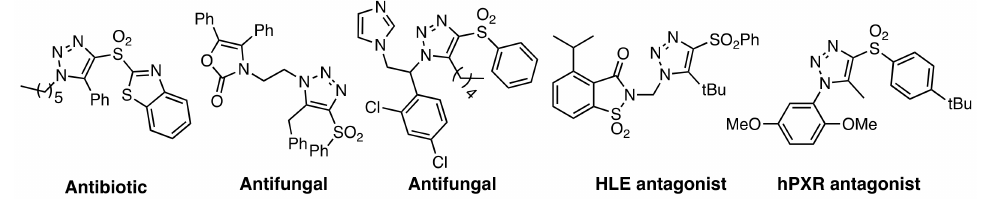
Figure 1. Examples of bioactive 4-sulfonyl